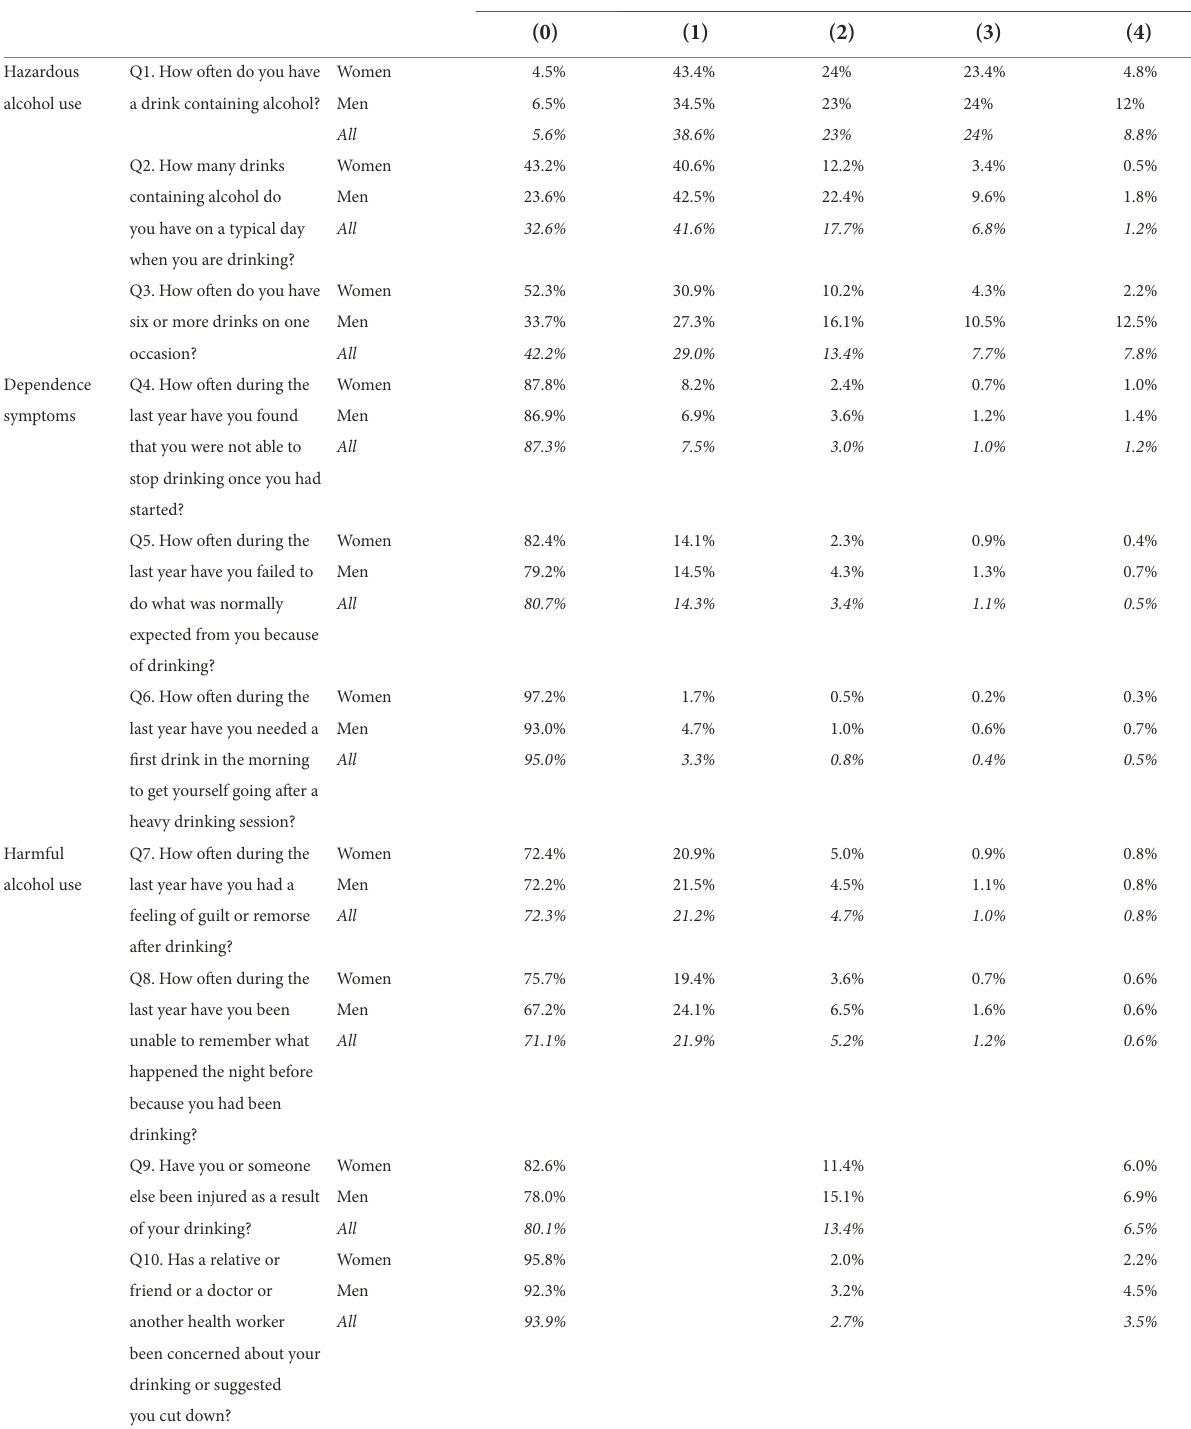
TABLE 2 Summary results of the AUDIT questionnaire according to the particular scores, domains, and genders.